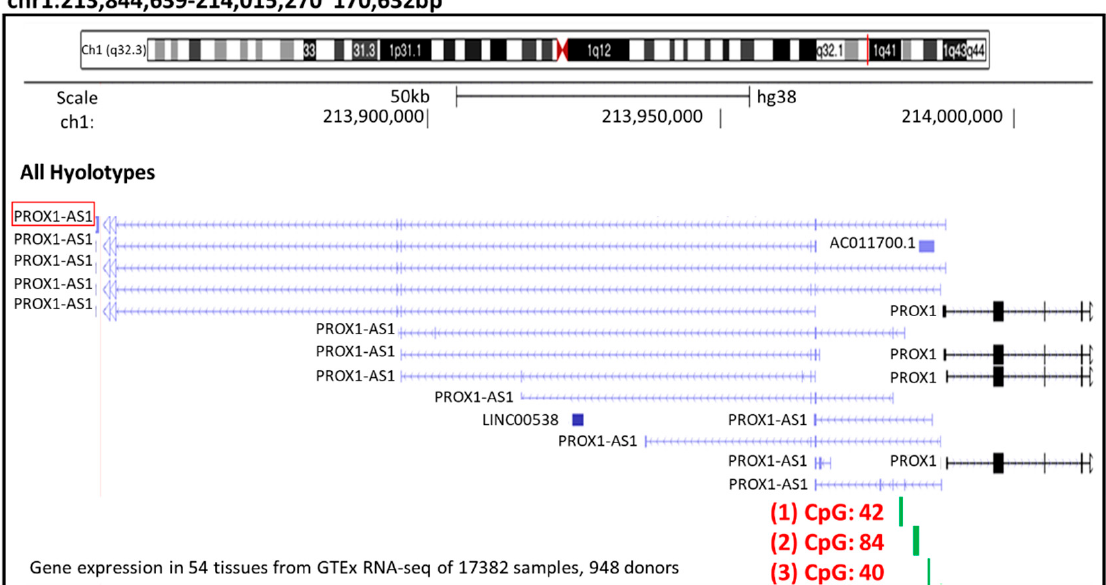
Figure 3. PROX1-AS1 promoter region CpG island analysis. In the methylation simulation performed in the lncRNA- PROX1-AS1 exon 1 and the gene’s promoter (start position chr1: 213,985,153–end position: 214,000,000, accession data: >NC_000001.11:213985153-214000000 Homo sapiens chromosome 1, GRCh38.p13 Primary Assembly), three CpG islands (1: CpG 42; 2: CpG 84 and 3: CpG 40) were selected with UCSC Genome Browser (http://genome-euro.ucsc.edu/; accessed on 9 April 2021). Table 4. The location and characteristics of the